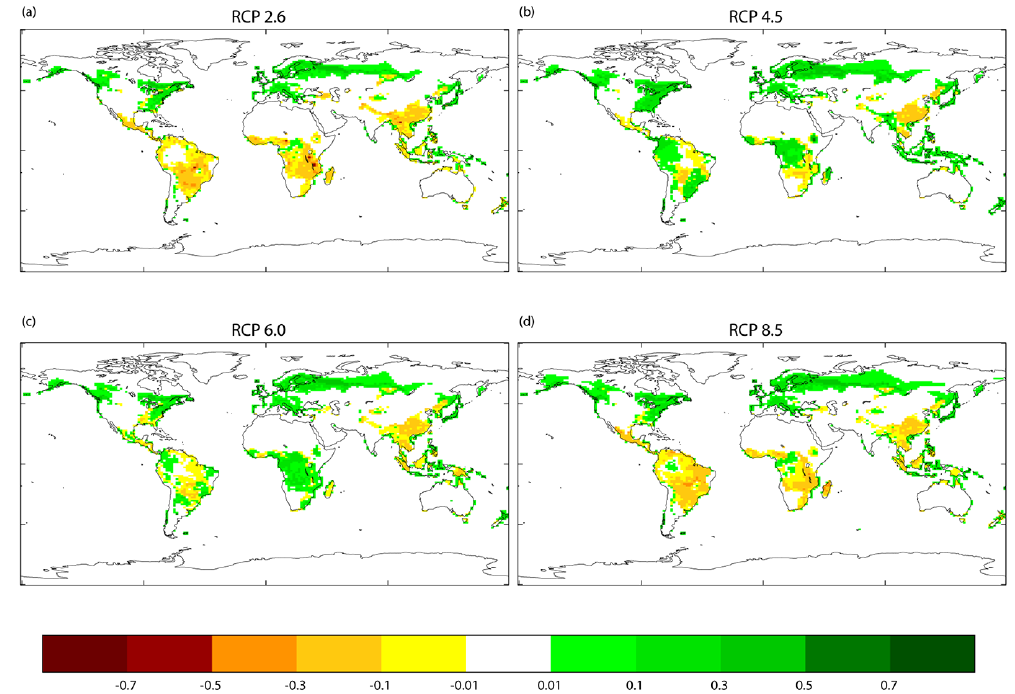
Figure 6. Changes in fractional cover of broadleaf tree by 2070–2099 relative to 1971–2000 simulated by HadGEM2-ES driven by scenarios of greenhouse gas and aerosol concentrations and land use following (a) RCP2.6 (b) RCP4.5 (c) RCP6.0 and (d)